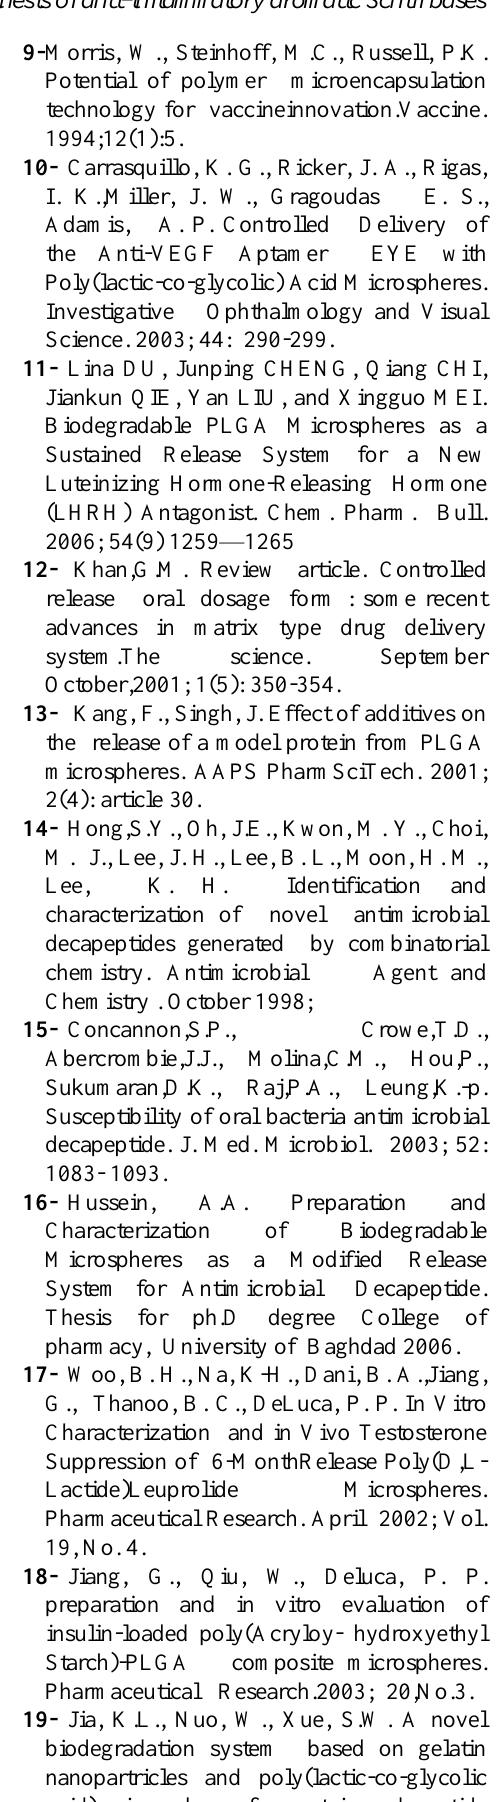
Figure 4: Release profile of 10% KSL peptide-loaded PLGAs microspheres in phosphate buffer, pH 7.4 at